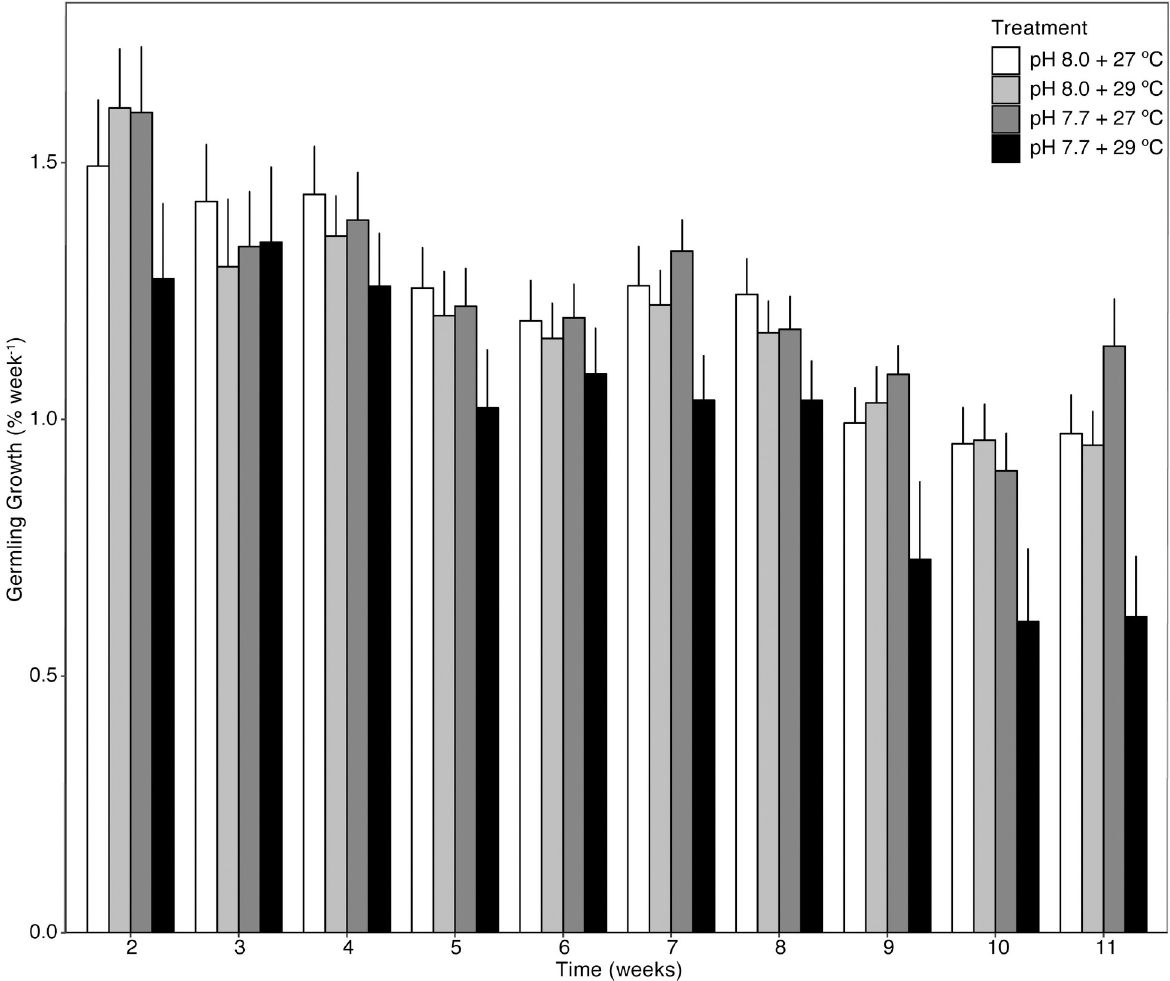
Fig 3. The percent growth of Sporolithon germlings across temperature and p CO 2 (pH) treatments from week to week over 11 weeks. Each bar represents mean % growth from each treatment at each time point ± SE. Data were log transformed to meet normality.